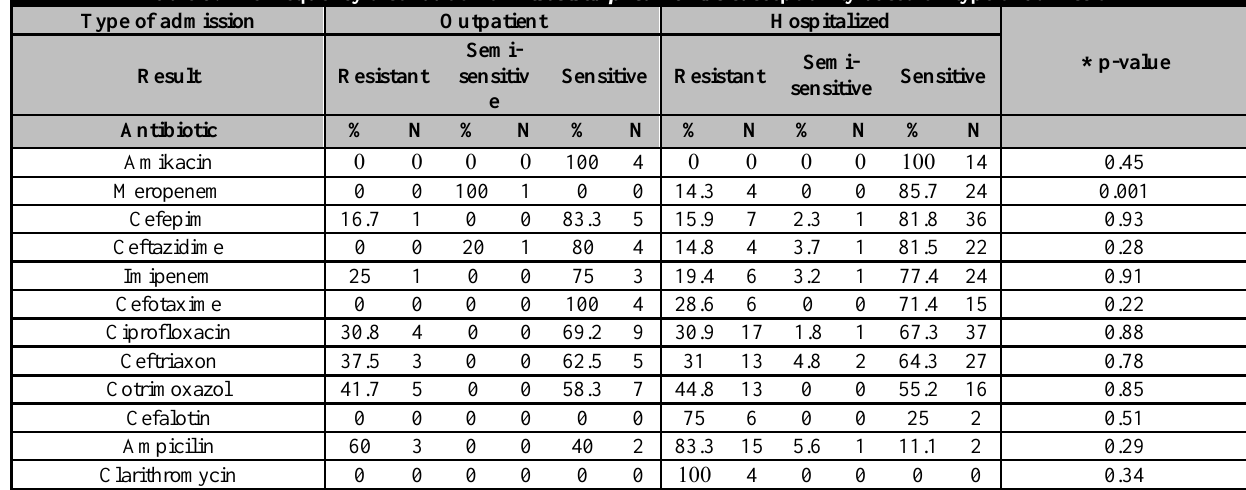
Table 3. The frequency distribution of Klebsiella pneumoniae susceptibility based on type of admission Type of admission